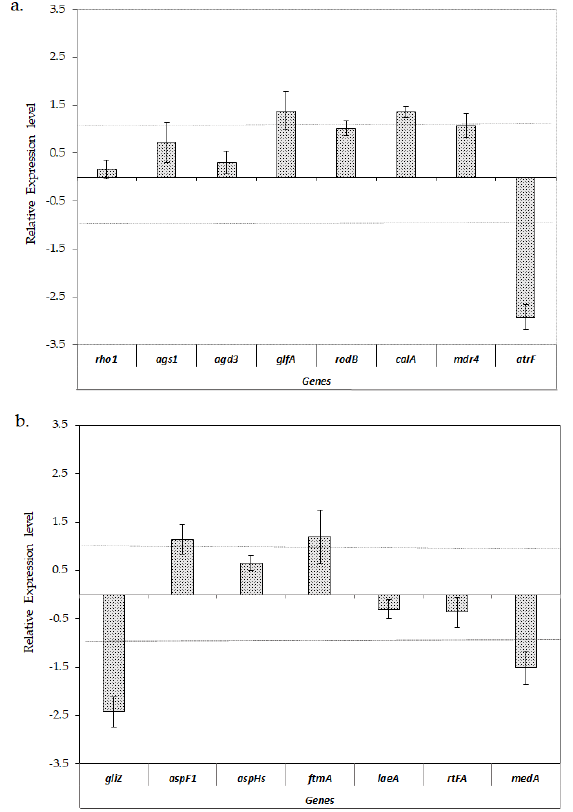
Figure 4. Relative expression ±S.D. of the virulence-related genes of A. fumigatus LMB-35Aa biofilms formed on polyester at 37 vs. 28 °C: ( a ) analysis of genes of the cell wall structure, hydrophobin, invasin and efflux transporters; and ( b ) the genes involved in mycotoxin biosynthesis, adhesion and secondary metabolism. Gene expression levels were normalized using β -tub and tef1 as the reference genes. The relative expression level is represented as a log 2 fold change; dotted lines indicates log 2 fold change thresholds of − 1 and 1.